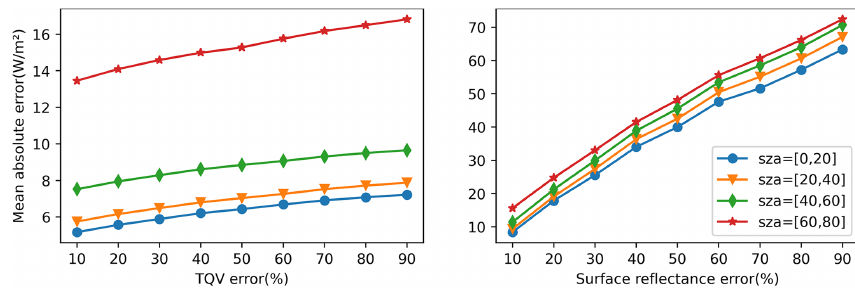
Figure 12. Sensitivity of the DSR retrieval algorithm to errors in the input data of surface reflectance and TQV.